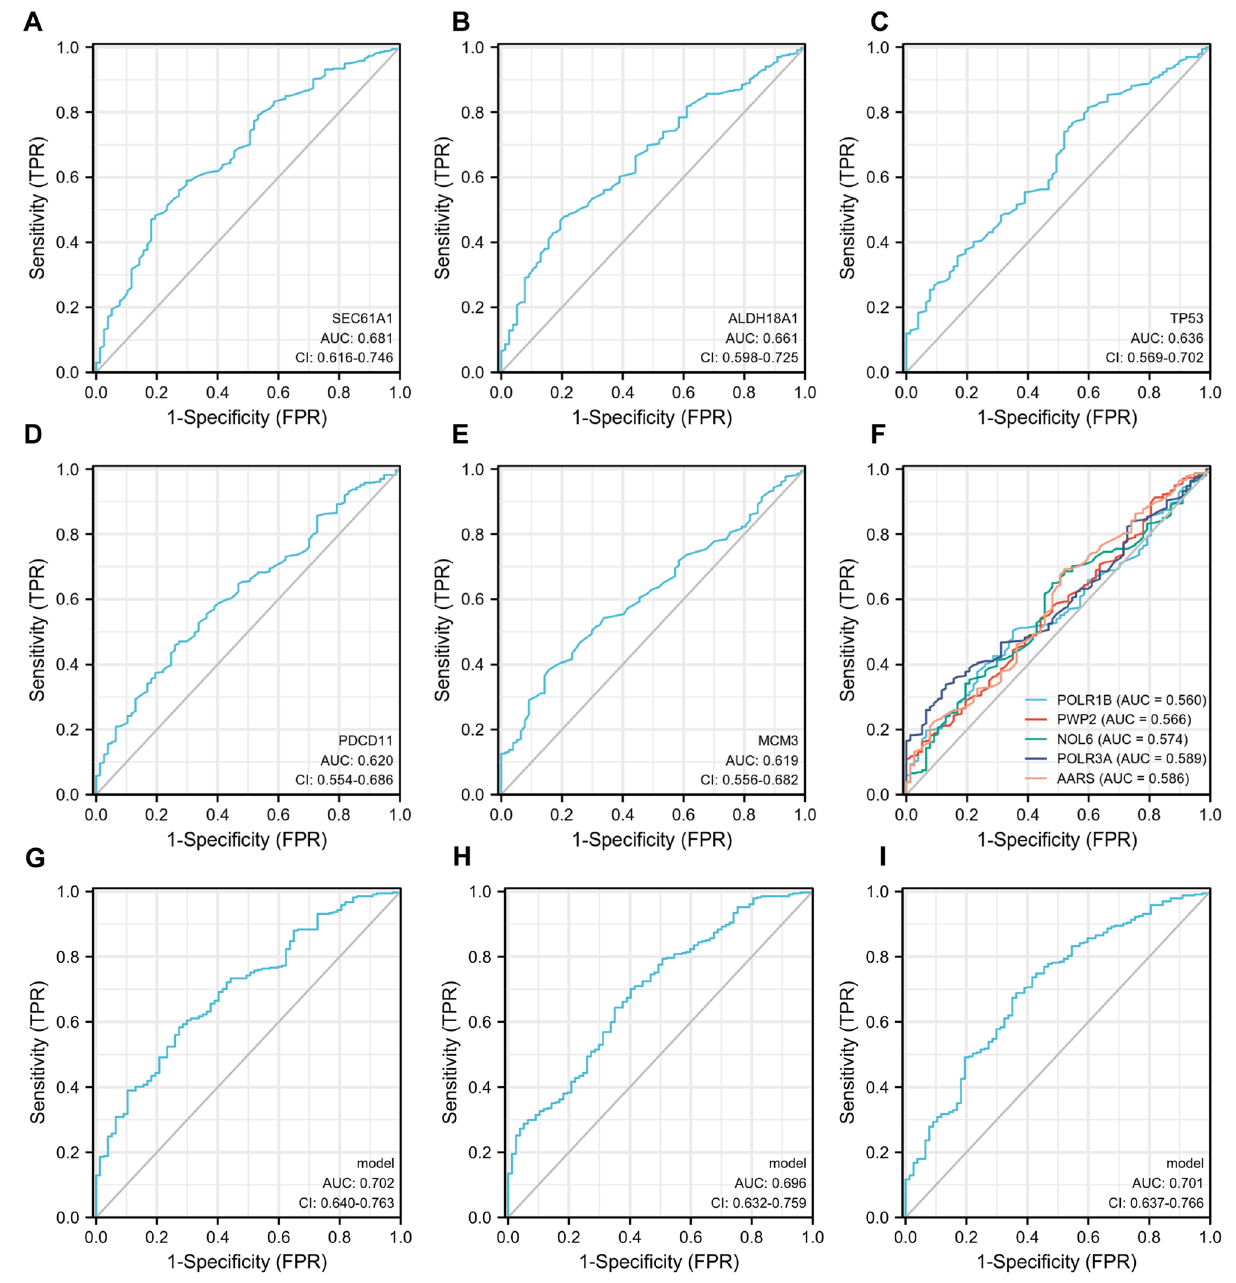
Figure 4. Evaluation of the hub genes. ROC (Receiver operating characteristic) curves for SEC61A1 ( A ), ALDH18A1 ( B ), TP53 ( C ), PDCD11 ( D ), MCM3 ( E ), the other five genes ( F ), combined 10 hub genes ( G ), combined AUC top 5 genes ( H ), and combined AUC top 2 genes ( I ). AUC area under the curve, CI Confidence and attenuated allergic inflammation in the human mast cells. Hence, the identified hub genes, TFs and miRNAs may contribute to the progression of asthma. Through the protein-chemical interaction analysis, we identified cyclosporine and acetaminophen may have effects on severe asthma. Cyclosporin, as an immunosuppressive agent, has benefits in the treatment of inflam- matory disorders. Patients with chronic severe asthma are dependent on the oral corticosteroids and alternative